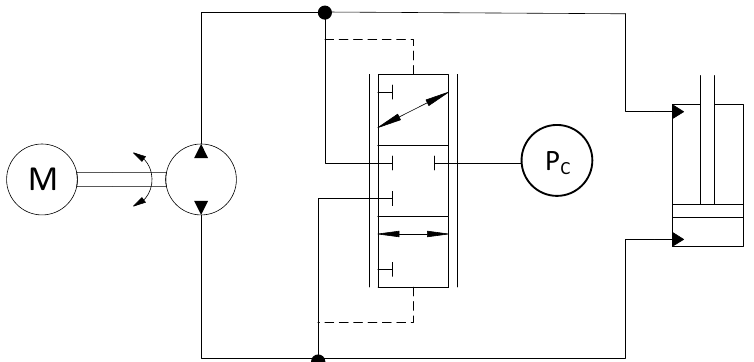
Figure 2. Schematic of the mini electrohydrostatic actuator (EHA), including variable speed motor, fixed displacement pump, inverse shuttle valve, low pressure charge oil supply, and hydraulic cylinder. Pressures acting on the valve shift the spool or poppet such that the low-pressure supply ( P c ) is connected to the lower of the pump ports for unbalanced flow compensation.